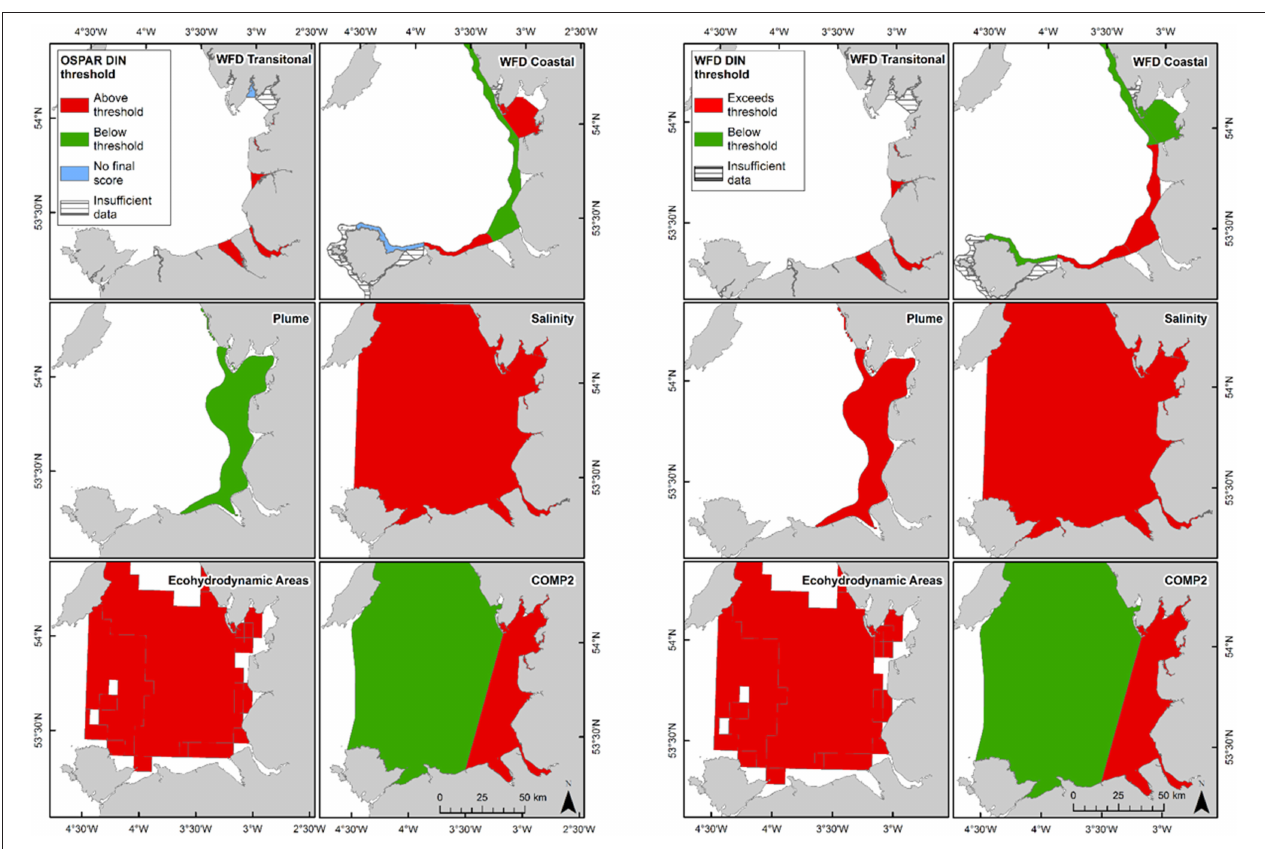
FIGURE 6 | Outcomes for the OSPAR DIN assessment (left) and WFD DIN assessment (right) for Liverpool Bay. salinity-defined, turbidity-defined and eco-hydrodynamic